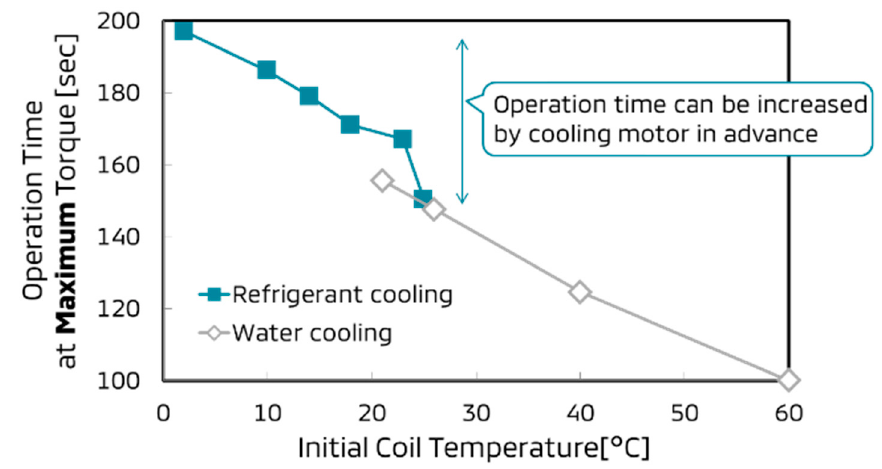
Figure 11. Operation time at maximum torque vs initial coil temperature.